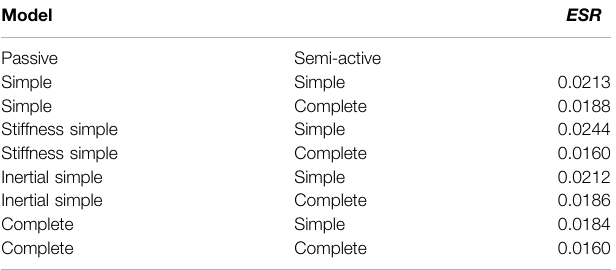
TABLE 14 | Model estimation performances using ESR